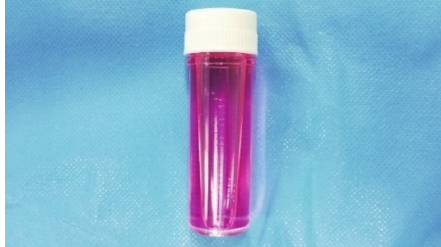
Figure 25 Cell preservation liquid for Thinprep cytologic